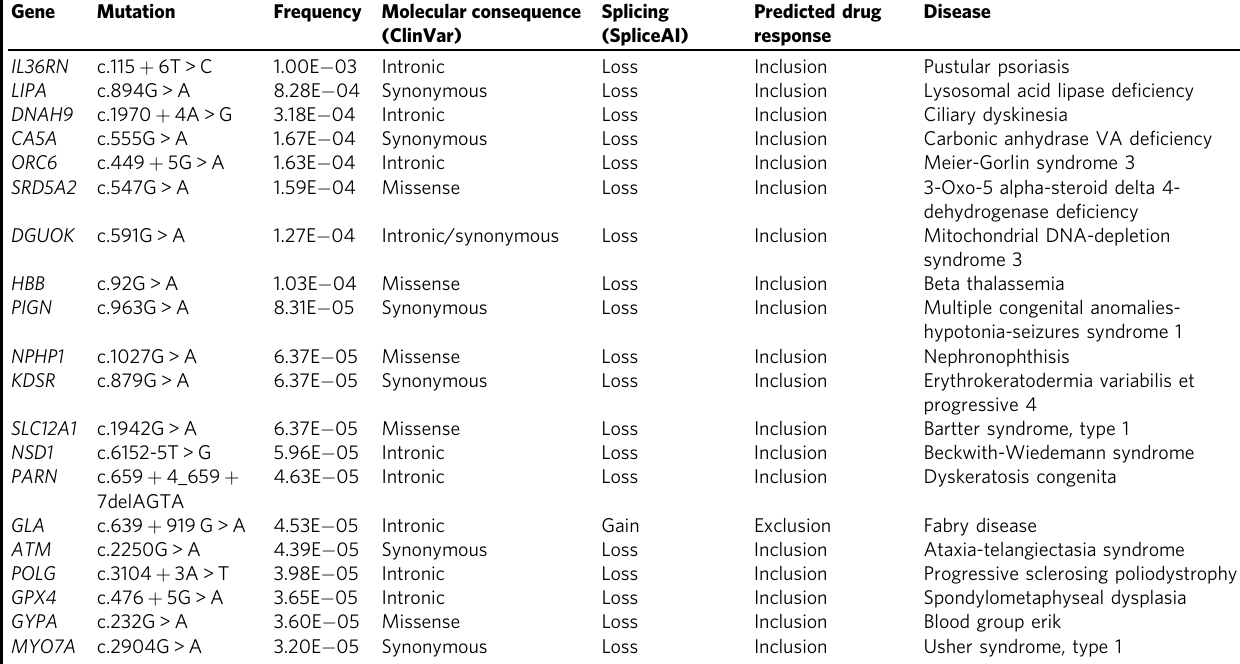
Table 1 ClinVar pathogenic mutations predicted to be rescued by BPN-15477 treatment and selected based on top populational allele frequencies in gnomAD